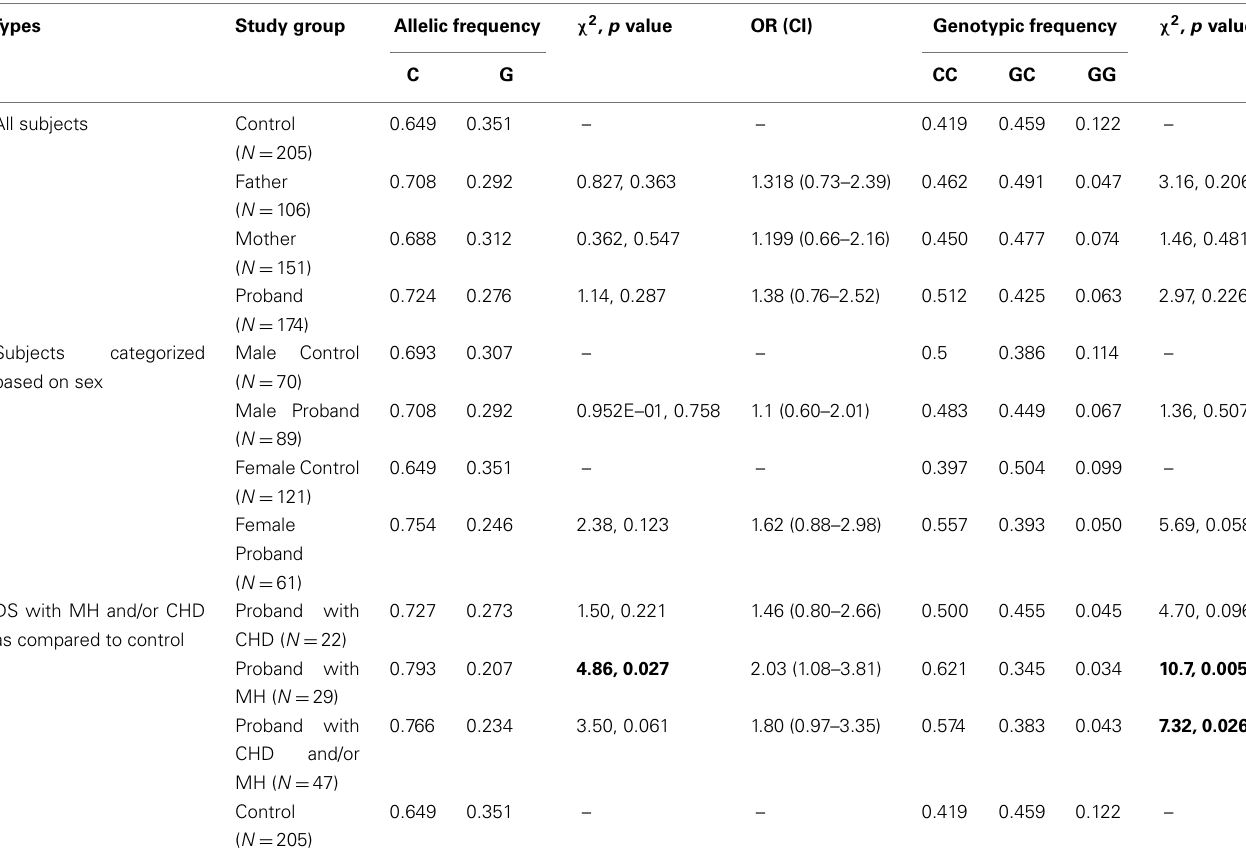
Table 3 |Allelic and genotypic frequencies observed in different